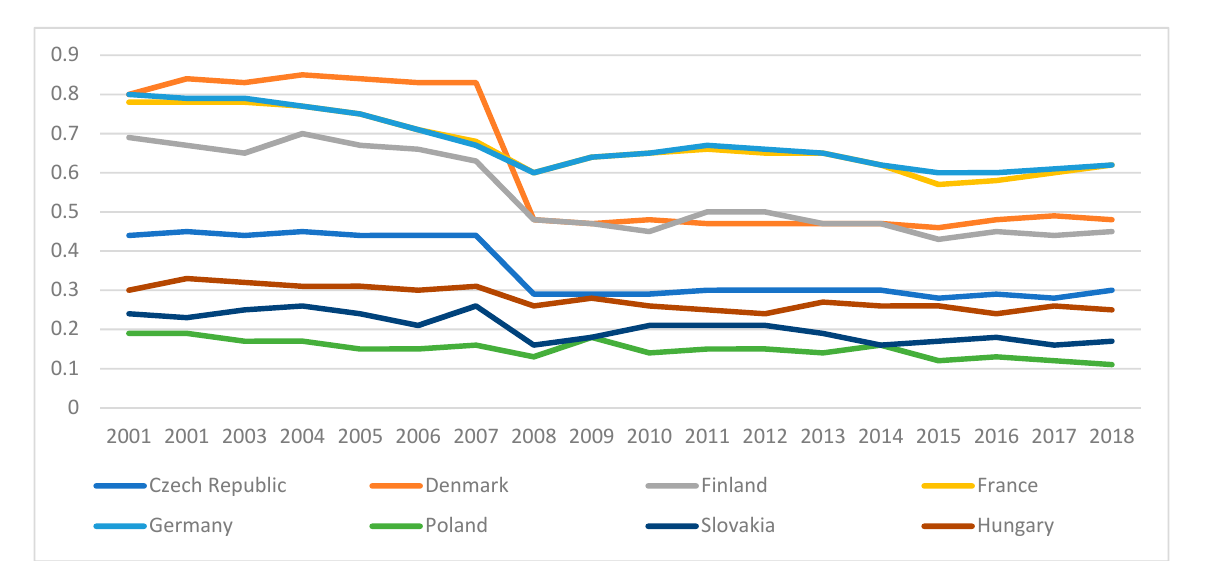
Figure 1. A synthetic indicator of the differential level of economic development in the EU countries studied, 2001–2018. Source: own elaboration based on Eurostat data [33].